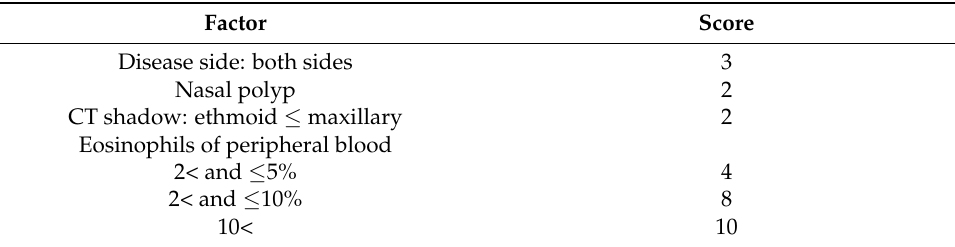
Table 1. Diagnostic criteria of eosinophilic chronic rhinosinusitis (Adapted from Ref. [27]). Factor Score Disease side: both sides 3 Nasal polyp 2 CT shadow: ethmoid ≤ maxillary 2 Eosinophils of peripheral blood 2< and ≤ 5% 4 2< and ≤ 10% 8 10<